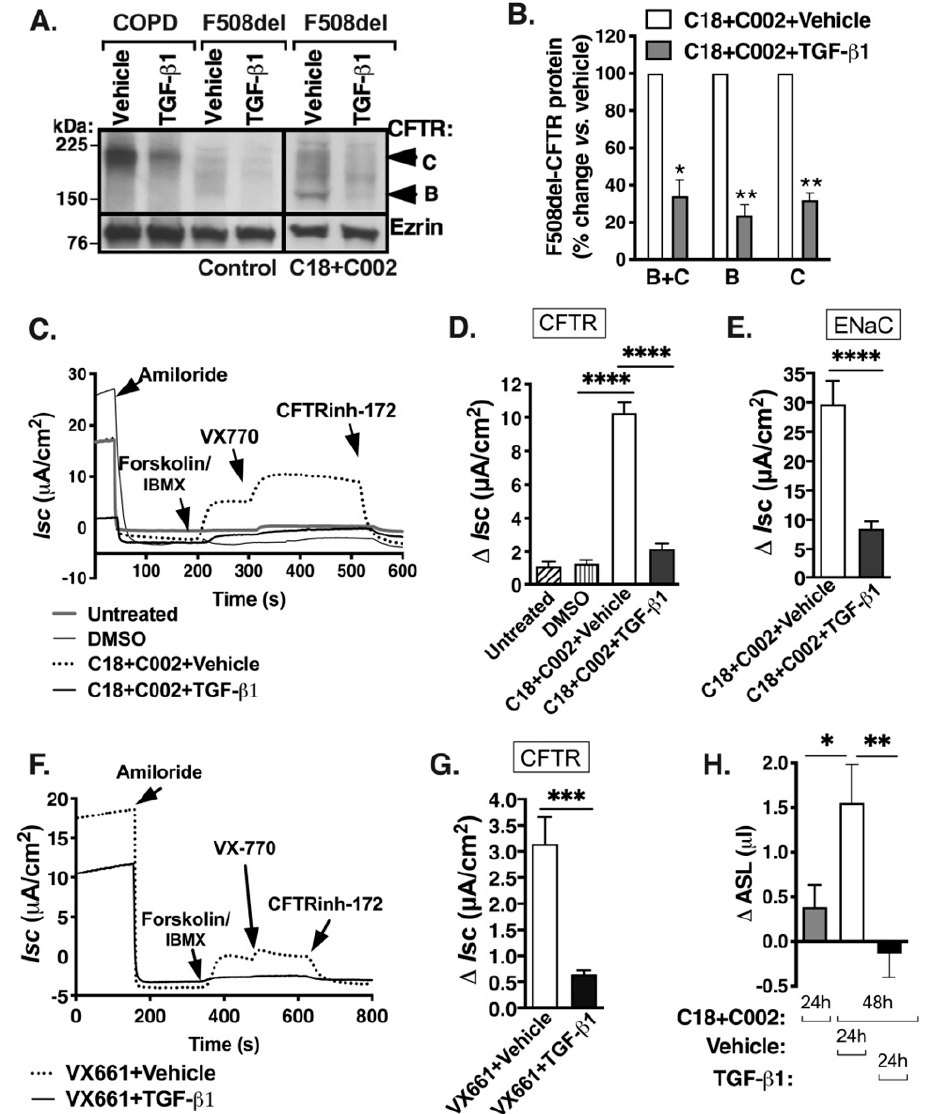
Figure 1. TGF- β 1 inhibits corrector rescue of the F508del-Cystic Fibrosis Transmembrane Conductance Regulator (CFTR) protein, channel function and airway surface liquid (ASL) volume in F508del HBE cells. Representative WB images ( A ) and summary of data ( B ) showing that the